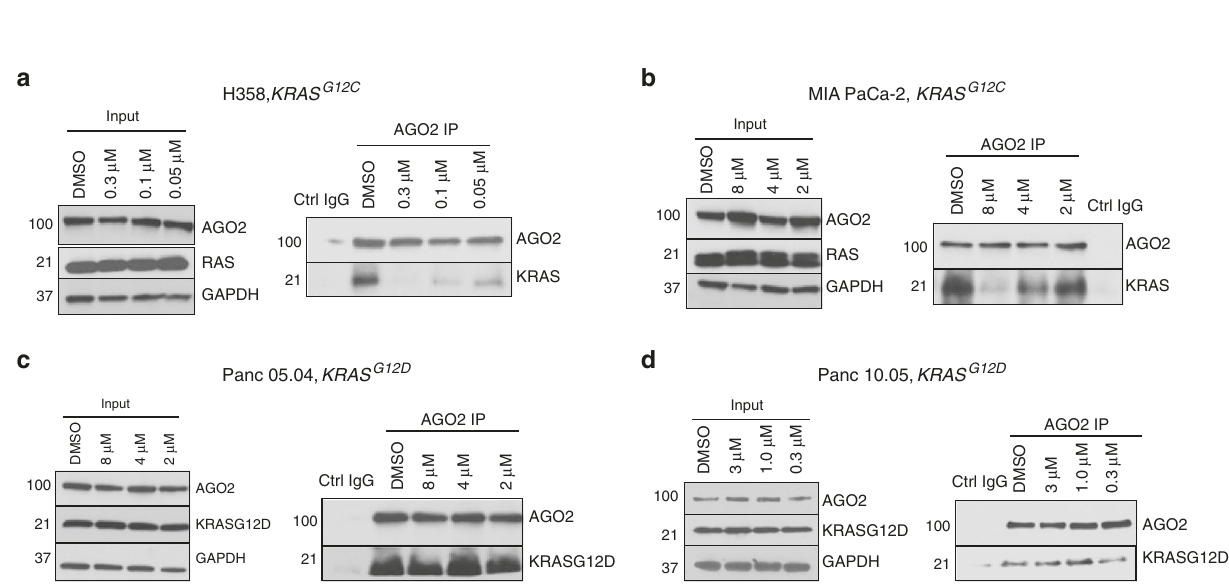
Fig. 8 ARS-1620, a G12C-speci fi c inhibitor, disrupts the KRAS G12C -AGO2 interaction. IP of endogenous AGO2 followed by immunoblot to detect KRAS in KRAS G12C harboring ( a ) H358 and ( b ) MIA PaCa-2 cells treated with varying concentrations of ARS-1620 for three and nine hours, respectively. KRAS G12D harboring ( c ) Panc 05.04 and ( d ) Panc 10.05 cells, respectively, treated with ARS-1620 for 24 h followed by AGO2 IP and immunoblot analysis of KRAS G12D . For each cell line, input blots for AGO2 and RAS are